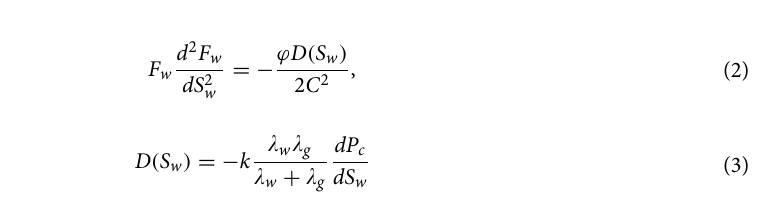
Figure 2. Quantitative insight into SI, phase distribution, and pore structure of the unconfined specimen. The plots show ( a ) the increment of N w over time with its corresponding C value and the final saturation of water and gas phases, ( b ) the pore and grain size distribution, and ( c ) the wetting and non-wetting phase clusters size distribution after SI for the unconfined